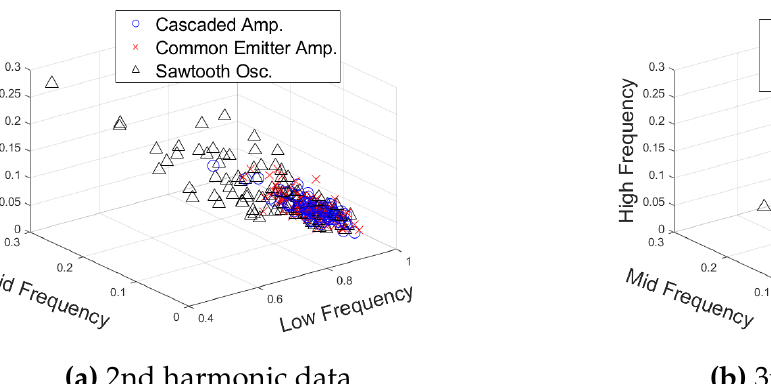
Figure 14. Classification performance of the Fourier features in harmonic space for varying SNR values.